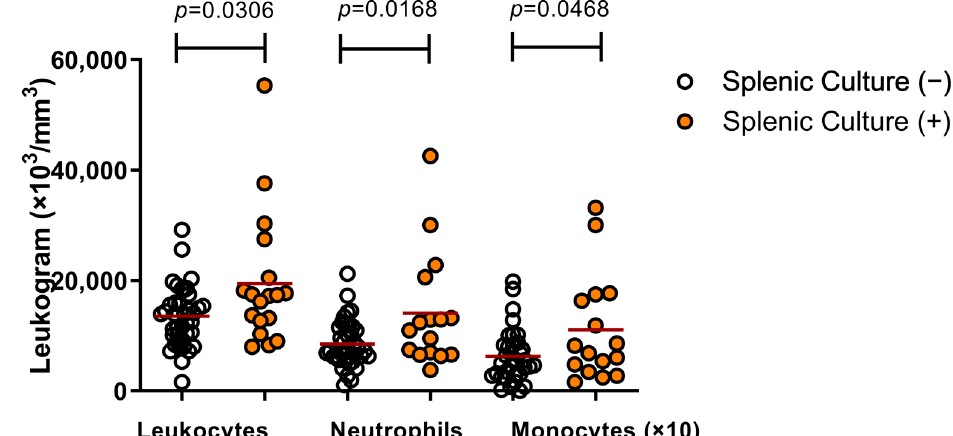
Figure 2. Changes in leukogram presented by dogs with active infection by L. infantum (Mann–